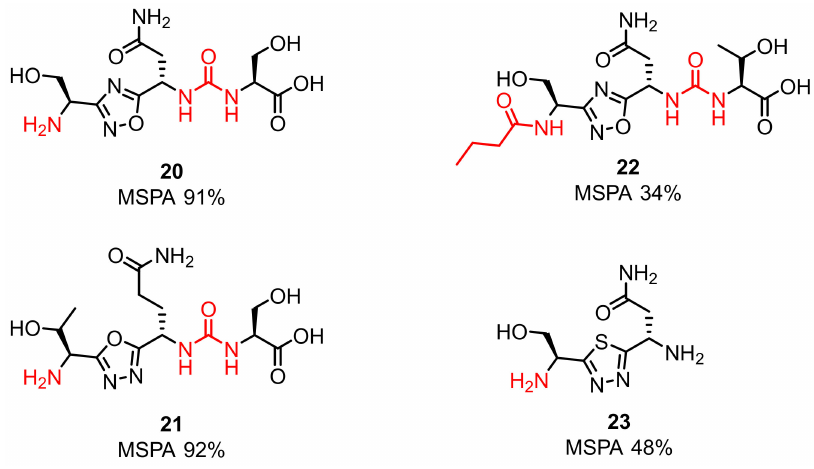
Figure 11. SAR of structures from Aurigene patents